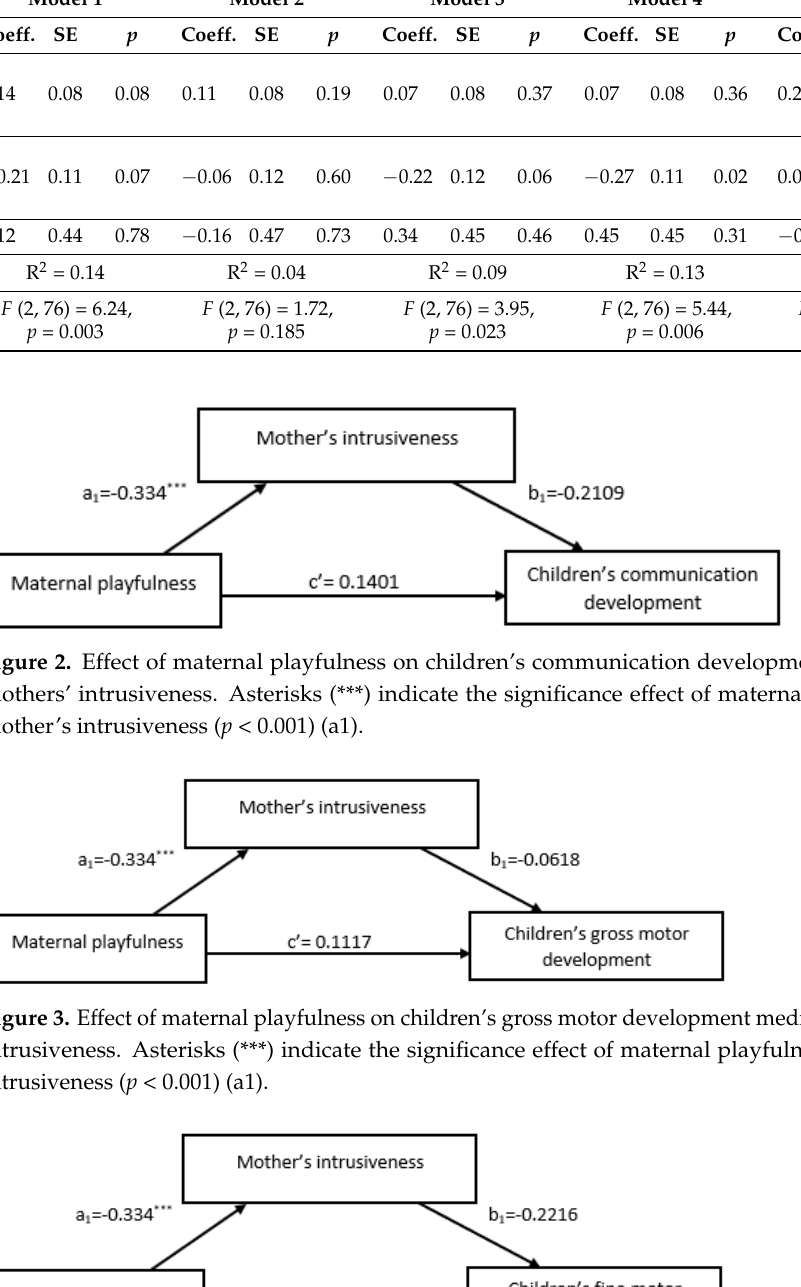
Figure 3. Effect of maternal playfulness on children’s gross motor development mediated by moth- ers’ intrusiveness. Asterisks (***) indicate the significance effect of maternal playfulness on mother’s intrusiveness ( p < 0.001) (a1). Figure 4. Effect of maternal playfulness on children’s fine motor development mediated by mother’s intrusiveness. Asterisks (***) indicate the significance effect of maternal playfulness on mother’s intrusiveness ( p < 0.001) (a1).